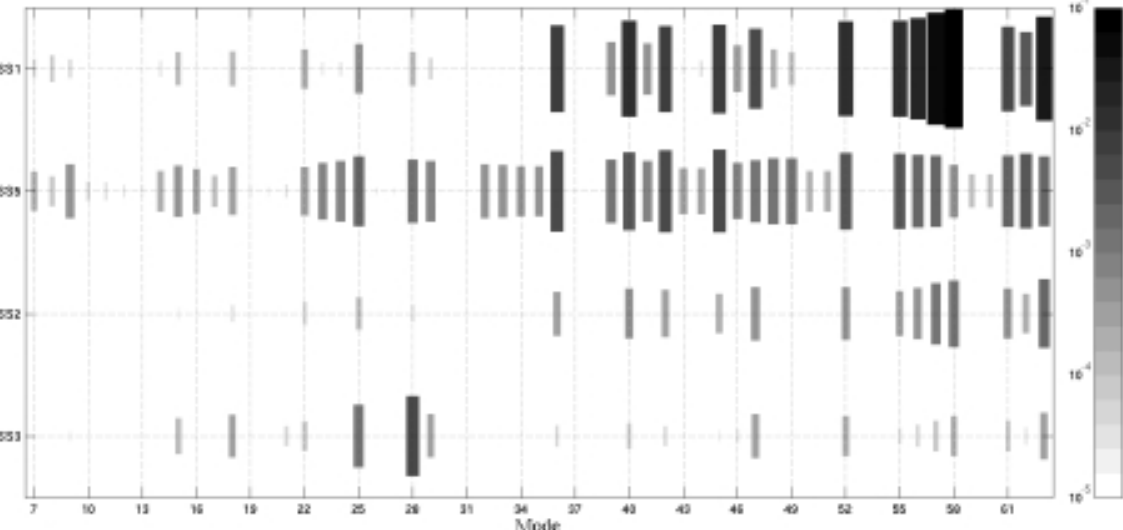
Fig. 6. Nominal superelement error localization.